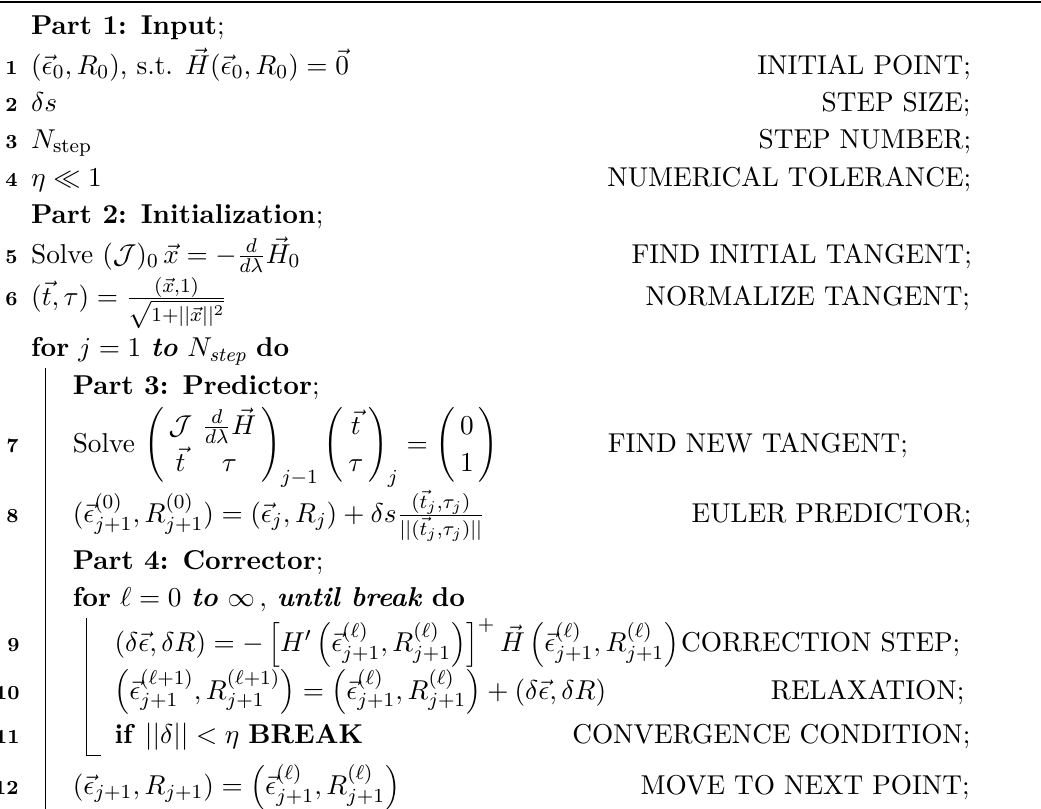
Algorithm 1: Euler-Newton predictor-corrector